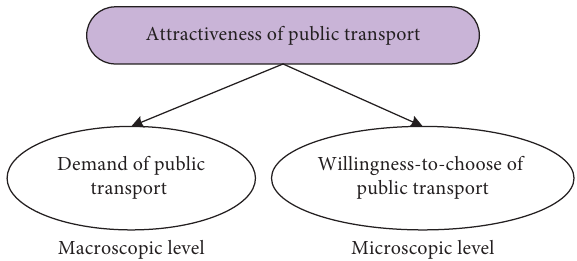
Figure 1: Research perspective of the attractiveness of public